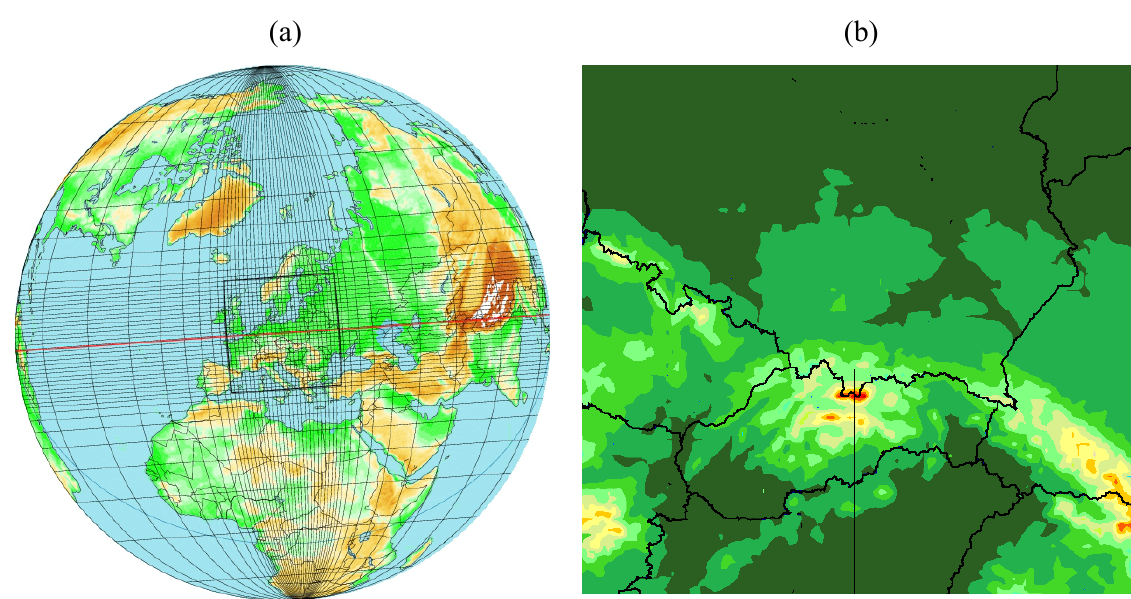
Figure 1. GEM-AQ grid setup for EcoForecast.EU: (a) global variable grid - 0.22 o over Fig. 1. GEM-AQ grid setup for EcoForecast.EU: (a) global variable grid – 0.22 ◦ over Europe; (b) nested LAM grid 0.0625 ◦